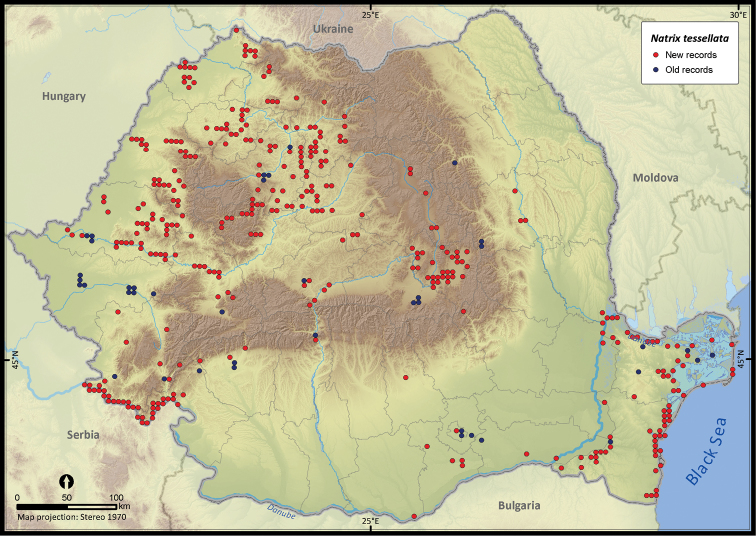
Natrix tessellata.